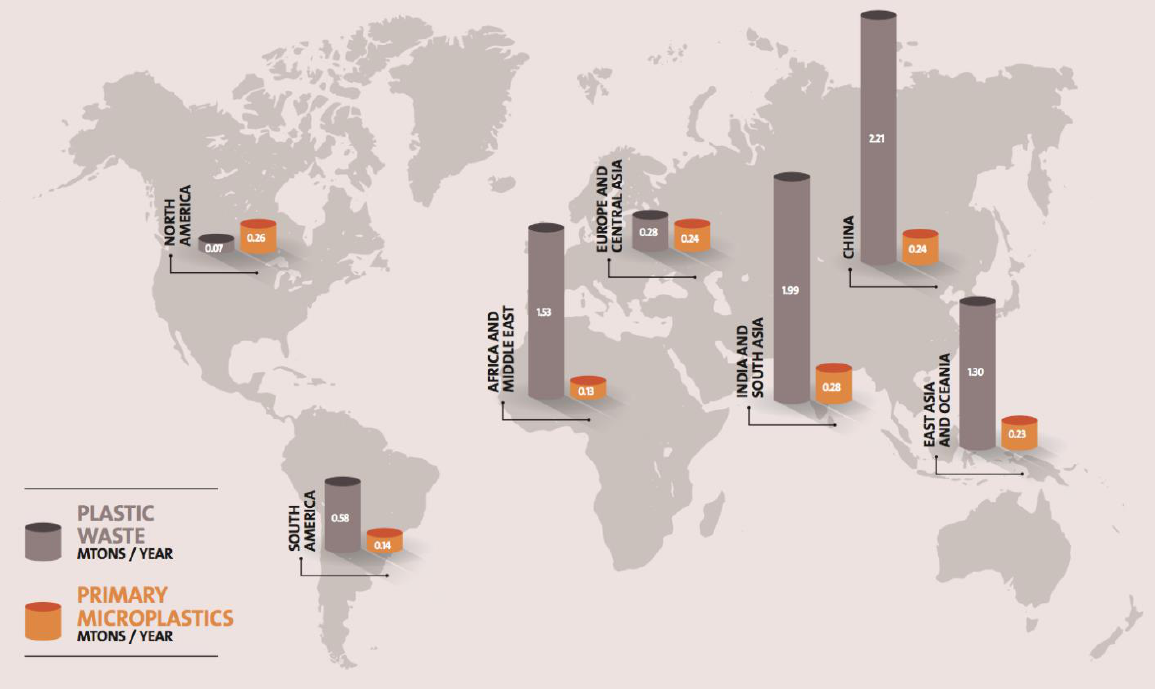
Figure 1. Amounts of plastic waste and primary microplastics generated worldwide